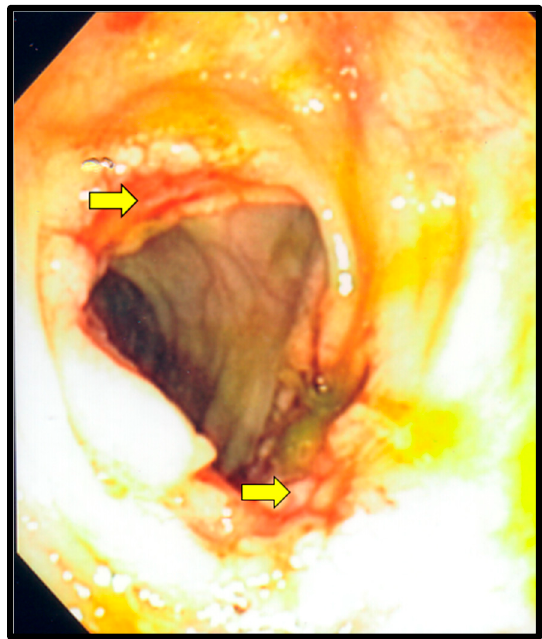
Figure 3. Colonoscopy. The yellow arrows point to ulcerations in the transverse colon, which were secondary to Histoplasmosis and cytomegalovirus co-infection.